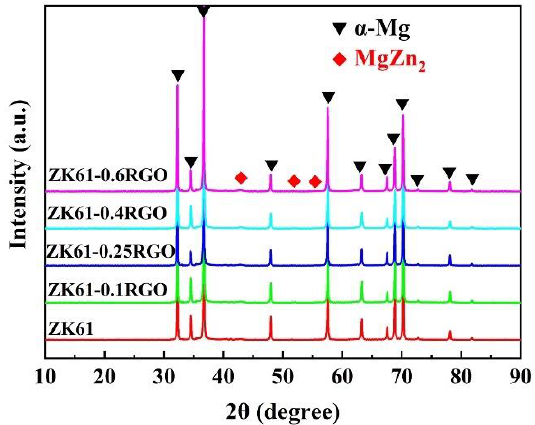
Figure 6. X-ray diffraction patterns of RGO-reinforced ZK61 matrix composites with different addi- tion of RGO.